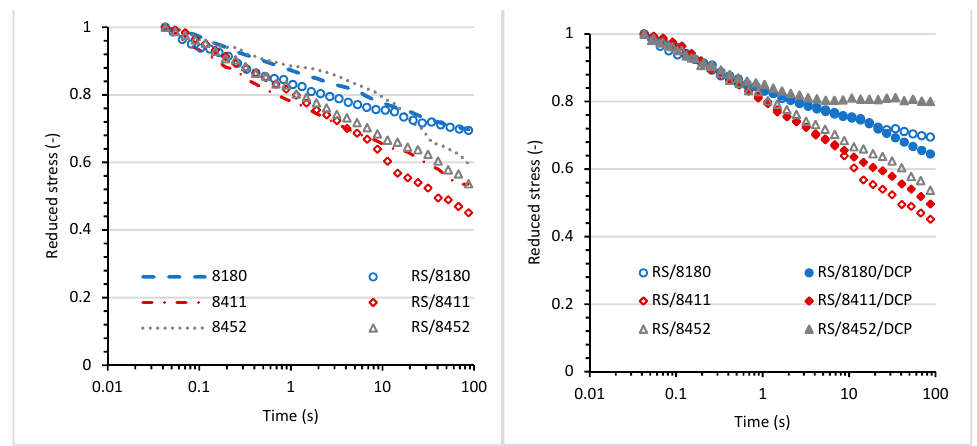
Figure 8. Reduced relaxation stress as a function of time.